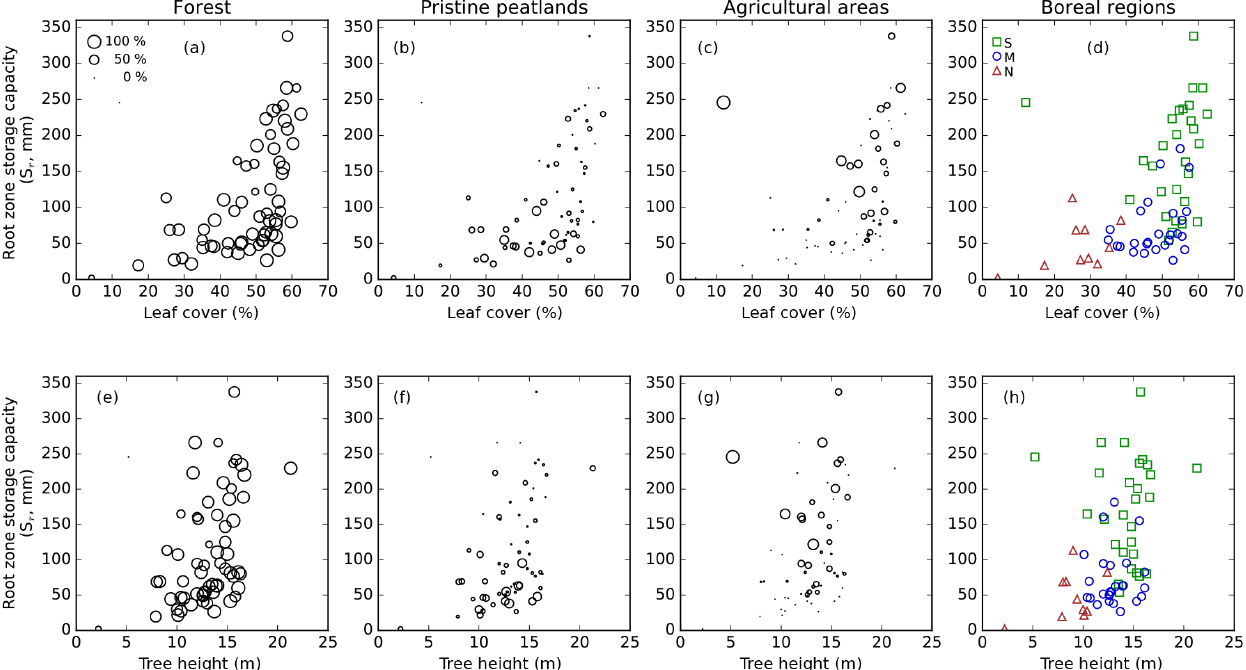
Figure 6. Calculated root zone storage capacity versus average leaf cover (a–d) and tree height (e–h) of 4 years. Larger circles indicate a higher percentage of vegetation type for (a, e) forest, (b, f) pristine peatlands and (c, g) agriculture; (d, h) are colour coded by boreal region. S r has statistically significant Spearman’s correlation with leaf cover ( r = 0 . 33) and tree height ( r = 0 . 32). Different boreal regions did not result in statistically significant correlations when considered